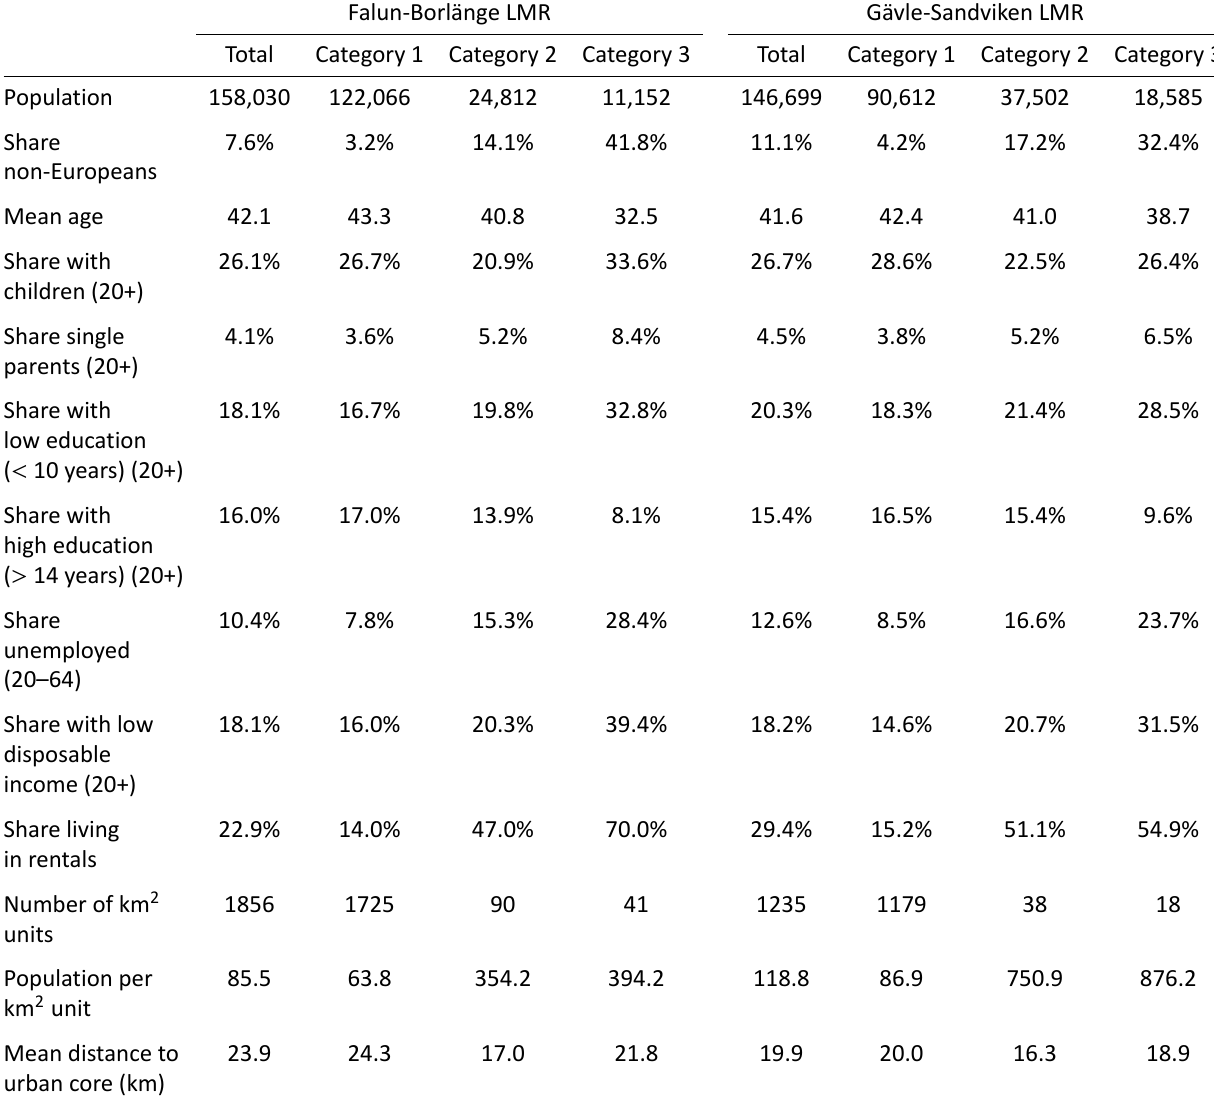
Table 1. Descriptive statistics of the two regions, total and by area